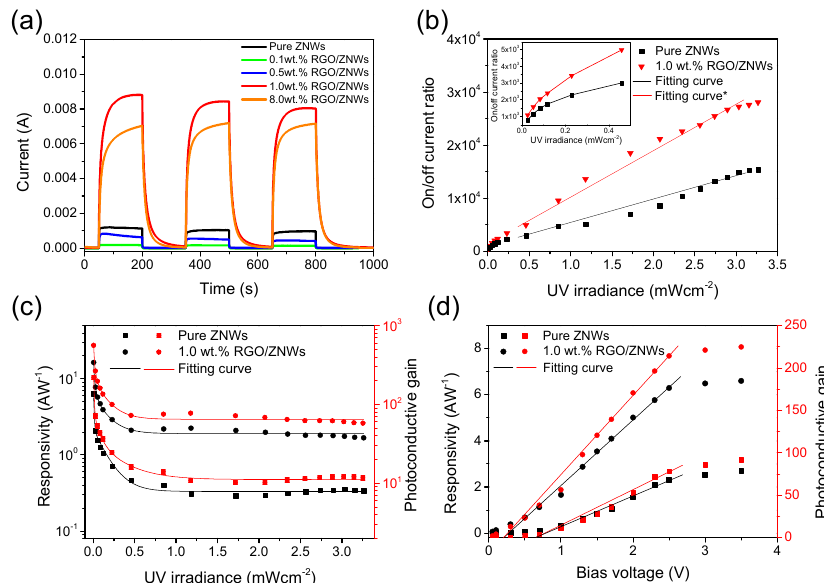
Figure 4. ( a ) Time-dependent photoresponses of photodetectors based on ZNWs and RGO/ZNWs composited with different contents under 3.26 mW·cm − 2 of UV irradiation controlled by switching on/off cycles and at a bias-voltage of 1.0 V; ( b ) Calculated on/off current ratio of photodetectors based on ZNWs and 1.0 wt % RGO/ZNWs composite. The inset is the magnification of on/off current ratio in low irradiation intensity; ( c ) UV intensity dependence of photoconductive gain and responsivity of photodetectors based on ZNWs and 1.0 wt % RGO/ZNWs composite at bias-voltage of 1.0 V; ( d ) Bias-voltage dependence of photoconductive gain and responsivity of photodetectors based on ZNWs and 1.0 wt % RGO/ZNWs.